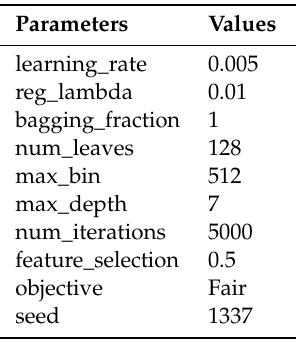
Table 5. The optimal hyperparameters set using the grid search